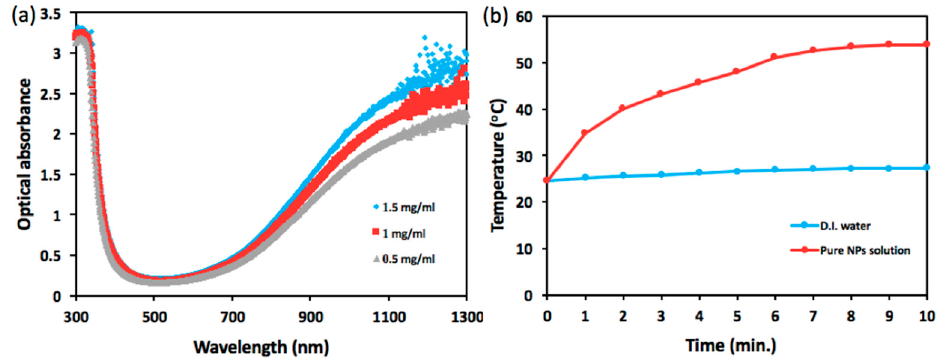
Figure 2. Optical measurement. ( a ) Optical absorbance spectra and ( b ) temporally dependent temperature of CsWO 3 NPs solution illuminated by near-infrared (NIR) laser beam with average power density of 6.25 W/cm 2 are illustrated.